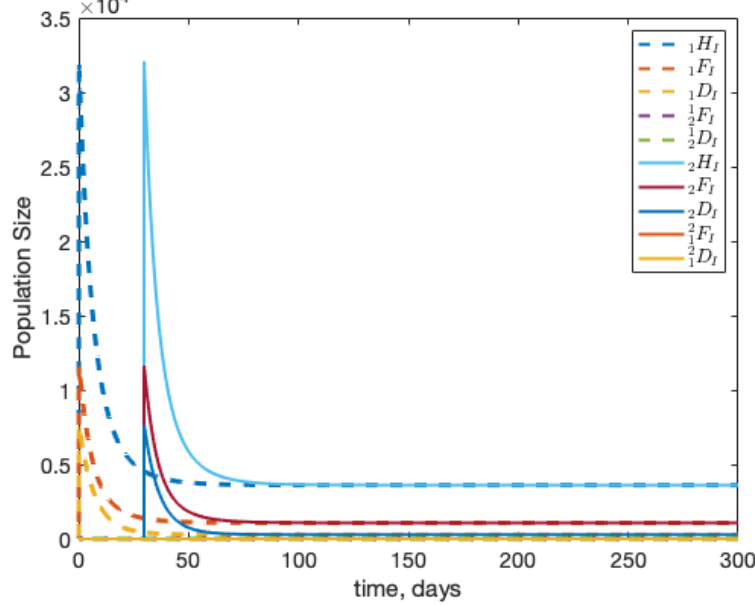
Figure 7. Beginning from equilibrium, we introduce one infected forager into colony 1 ( 1 F I ( 0 ) = 1). In this scenario, we remove drift but allow colony 2 to rob colony 1 of resources as the colony begins to die. We see that in this case the colonies behave